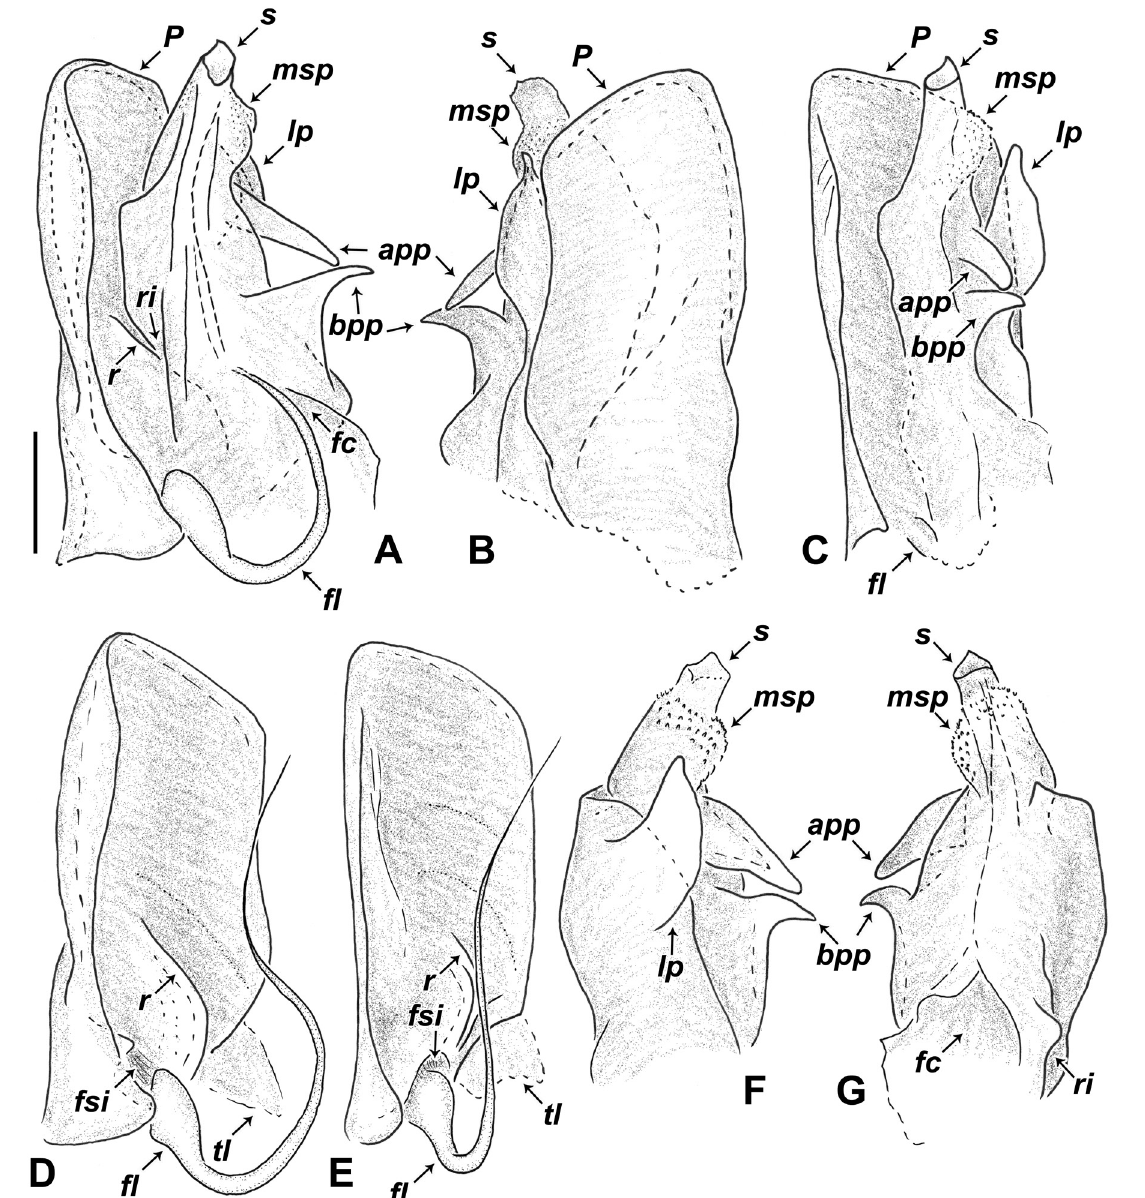
Fig. 2. Gonopods of Enghophyllum sifnium gen. et sp. nov., holotype ♂ . A . Left gonopods, mesal view. B . Left gonopods, antero-lateral view. C . Left gonopods, meso-posterior view. D . Left promere, meso-posterior view. E . Left promere, postero-mesal view. F . Right opisthomere, lateral view. G . Right opisthomere, mesal view. – app = apical posterior process; bpp = basal posterior process; fc = flagellum channel; fl = flagellum; fsi = flagellum sinus; lp = lateral process; msp = micro-spinose pillow; P = promere; r = ridge; ri = riffle; s = solenomere; tl = triangular lamella. Scale bar: 0.2